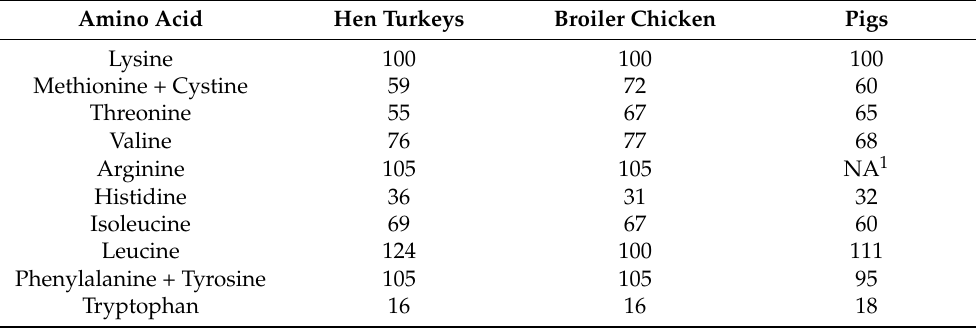
Table 3. Estimated ideal protein ratio for a starting hen, broiler, and pig, expressed as a lysine needed percentage [70]. Amino Acid Hen Turkeys Broiler Chicken